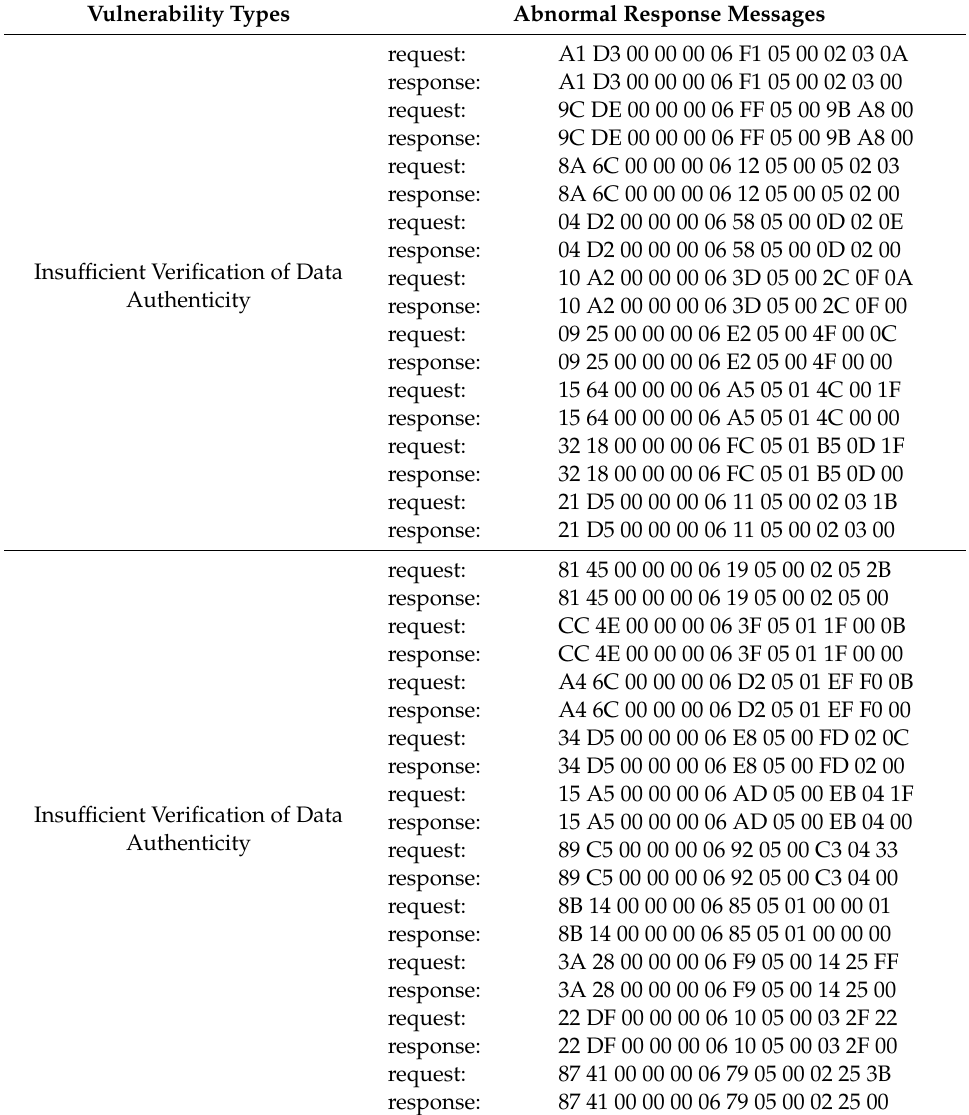
Table A1. All the abnormal response messages that cause the insu ffi cient verification of data authenticity